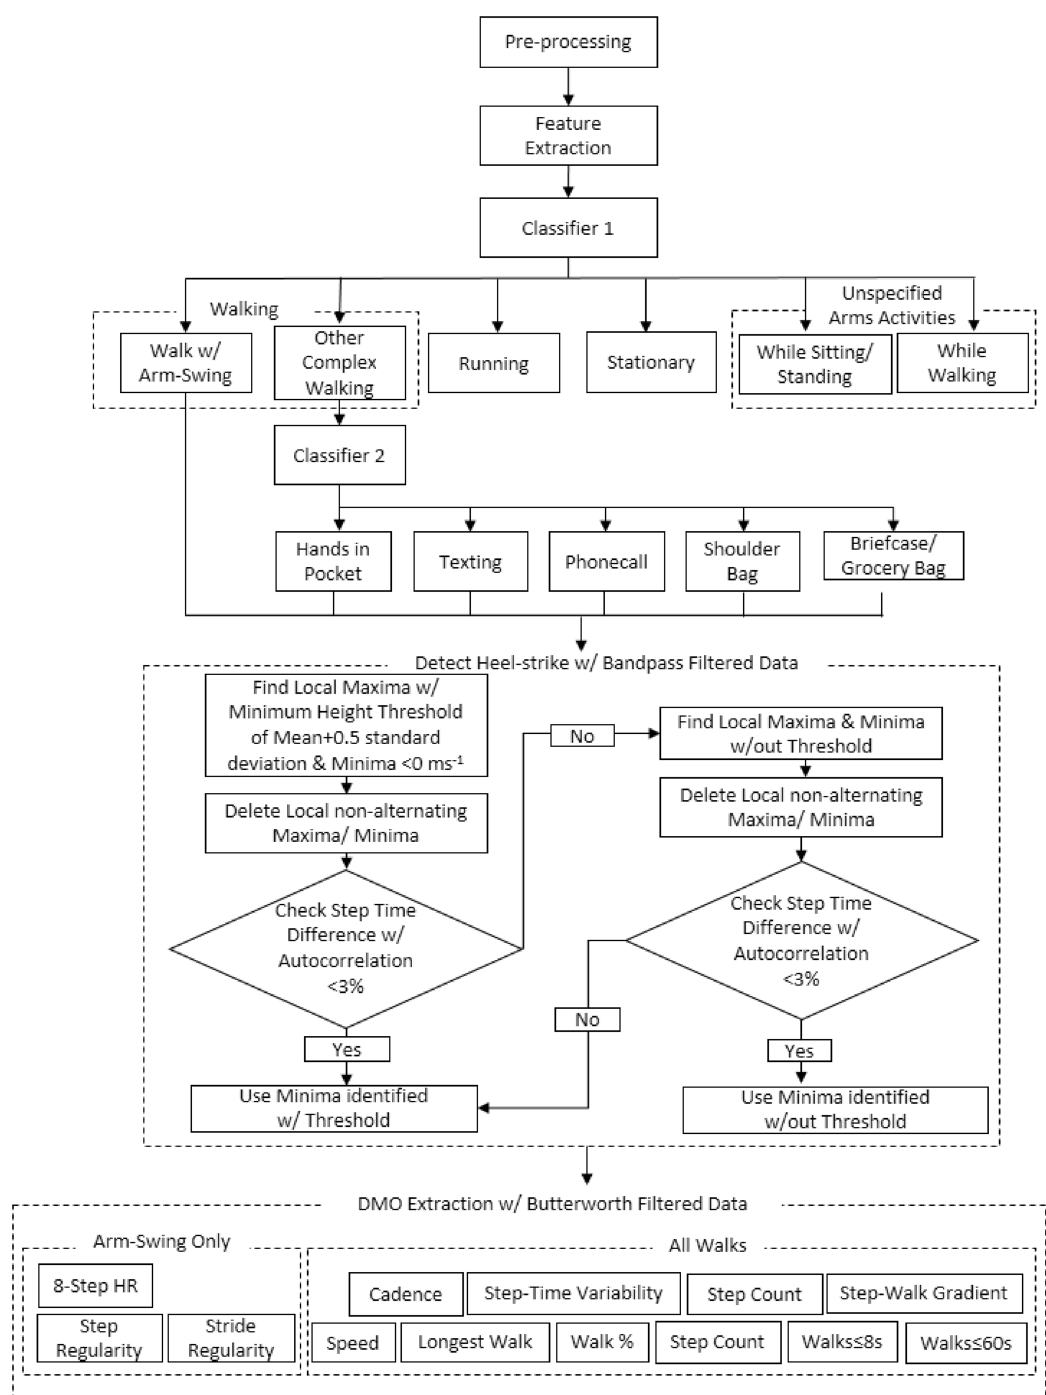
Figure 6. Hierarchical framework of digital gait biomarker extraction (Stage